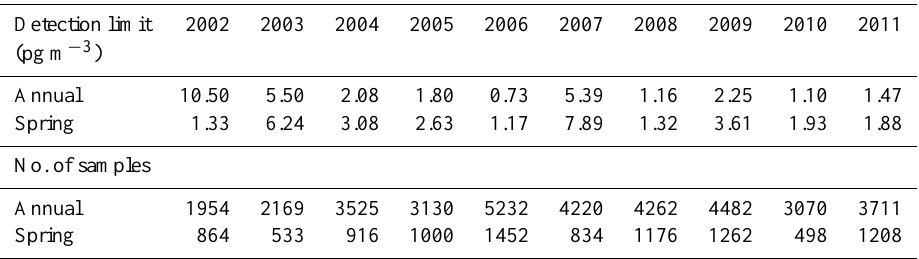
Table 1. Detection limits for each year for annual and springtime speciation measurements and the number of samples represented for each data point from 2002 to 2011 at Alert, Canada. Detection limits are reported in pgm − 3